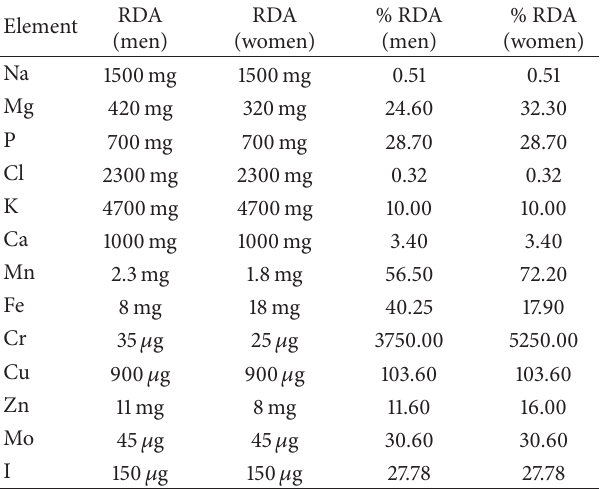
Table 2: Recommended daily allowance: mg (RDA, lit values) and percentage RDA of elements in UNCP.